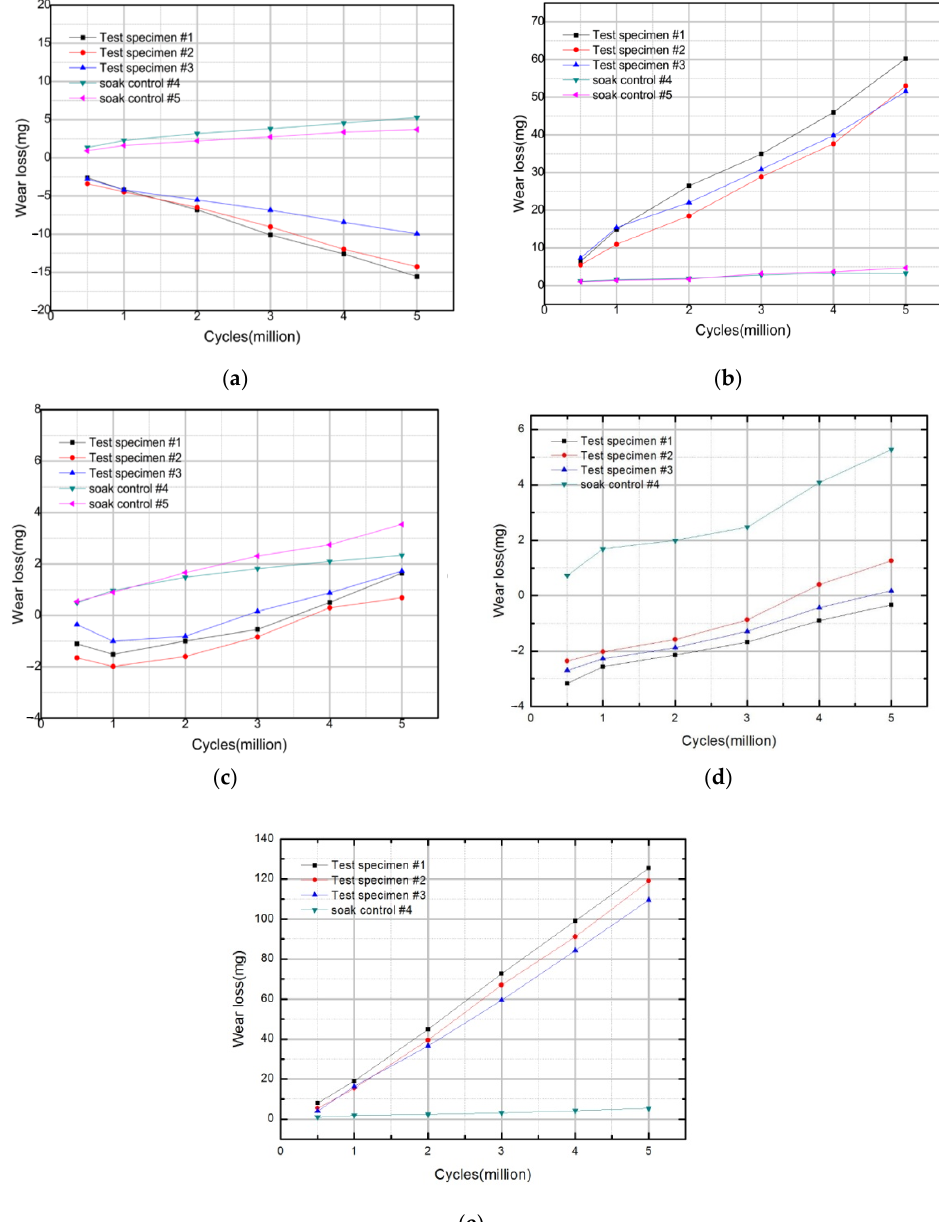
Figure 2. Gravimetric wear of the five test groups: ( a ) Group1; ( b ) Group2; ( c ) Group3; ( d ) Group4; ( e ) Group5 (see Table 2). Table 2. Wear rate after 5 × 10 6 cycles.